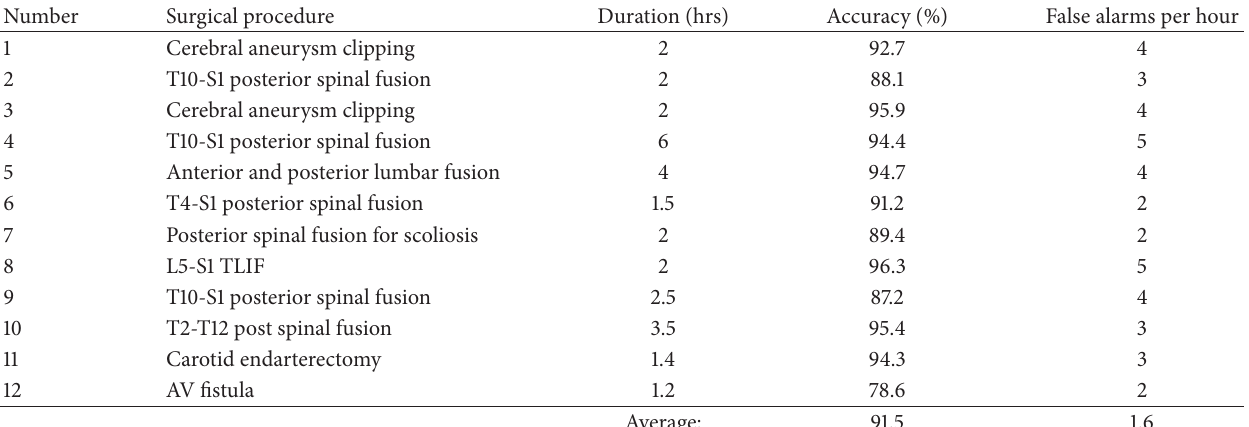
Table 1: Algorithm implementation and results. Description of the 12 surgical procedures including the procedure they underwent and the time for which the patients were monitored using SSEP and the algorithm implementation results including the accuracy and the number of false alarms detected per hour.